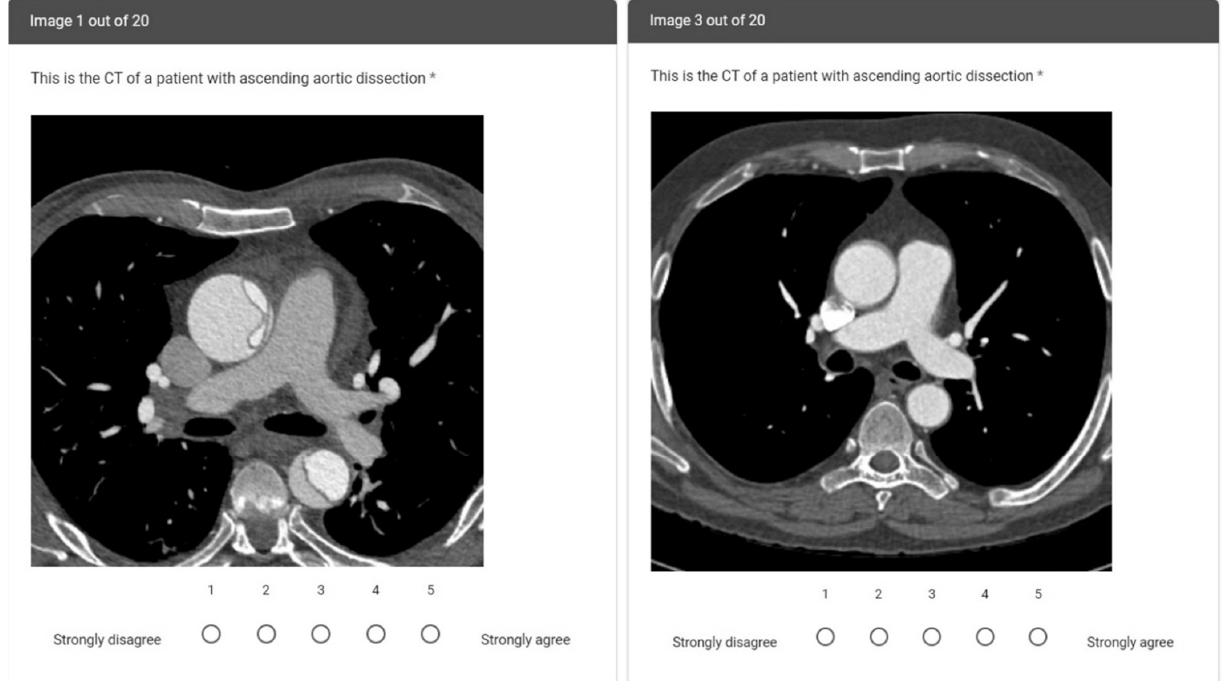
Figure 1. Sample survey questions from patients with ECG gating and aortic dissection (left) and without ECG gating and without aortic dissection (right). On the ECG gated CTA image, the ascending aortic dissection flap is clearly visible. On the non-ECG gated CTA image, there is movement around the ascending aorta, leading to challenges in diagnostic confidence. * was used to mark the question as mandatory.